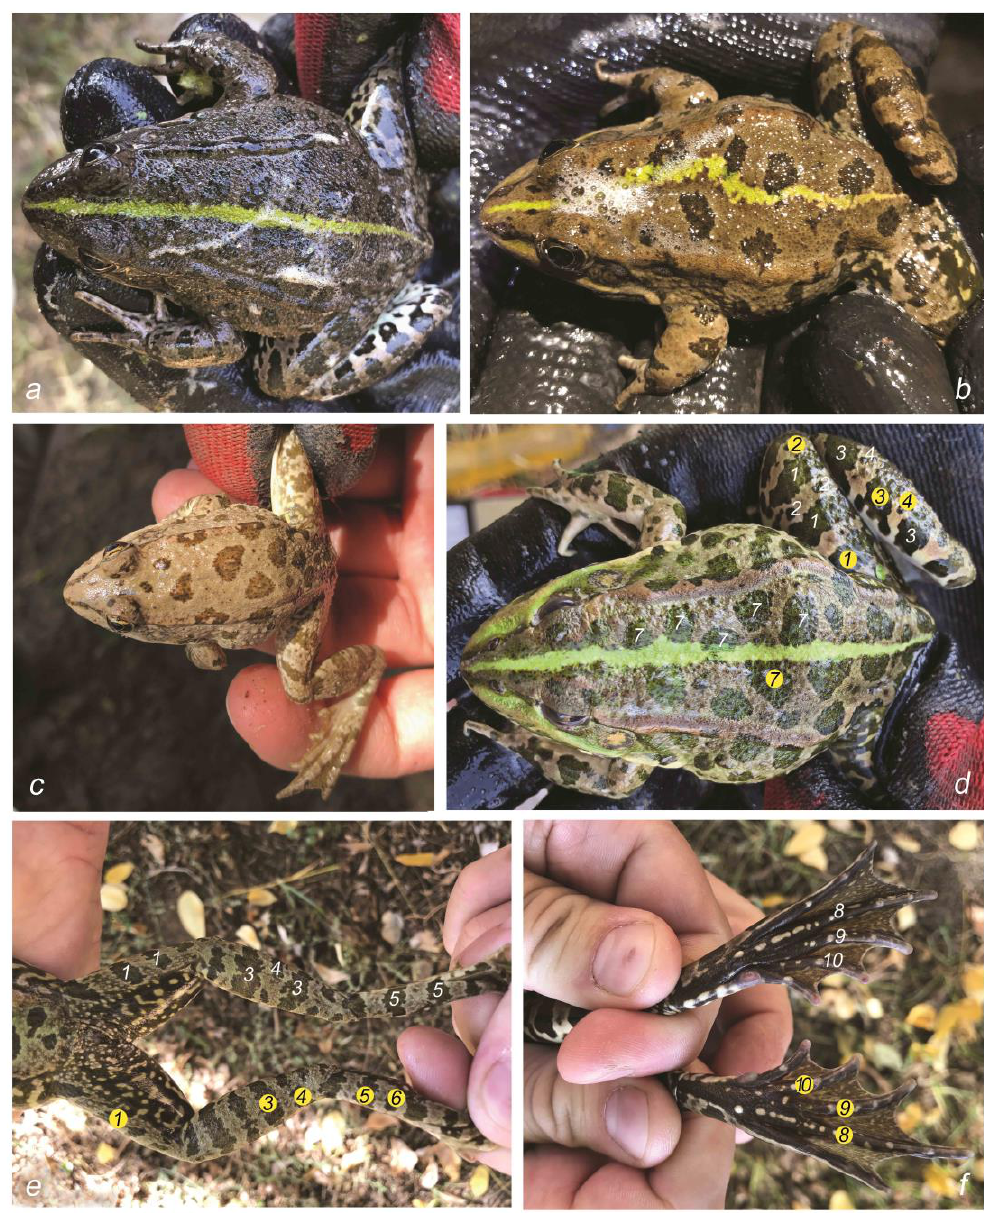
Figure 2. Adult P. ridibundus individual with low levels of asymmetry ( A ), adult P. ridibundus individual with high levels of asymmetry ( B ), subadult P. ridibundus individual with high levels of asymmetry ( C ), asymmetric morphological traits ( D – F ): trait 1 — number of stripes on the dorsal side of the thigh (femur); trait 2 — number of spots on the dorsal side of the thigh; trait 3 — number of stripes on the dorsal side of the shank (crus); trait 4 — number of spots on the dorsal side of the shank; trait 5 — number of stripes on the foot (pes); trait 6 — number of spots on the foot; trait 7 — number of stripes and spots on the back (dorsum); trait 8 — number of white spots on the ventral side of the second finger of the hind leg; trait 9 — number of white spots on the ventral side of the third finger of the hind leg; trait 10 — number of white spots on the ventral side of the fourth finger of the hind leg.